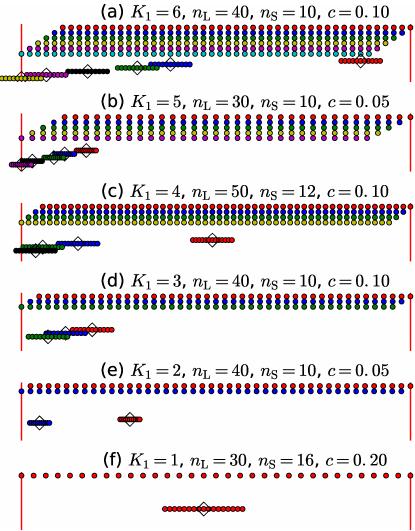
Fig. 1.— Arbitrary tested frequencies. (a) Six highest longer rows show tested frequencies f 1 > f 2 > f 3 > f 4 > f 5 > f 6 for K 1 = 6 signals and n L = 40 in a long search between P − 1 max and (vertical red lines). Six lower shorter rows show short search P − 1 min frequencies for n S = 10 and c = 0 . 10, where diamonds denote best frequency candidates f i , mid detected in long search. Symbol colours are given in Table 1. (b-f) Arbitrary tested frequencies for K 1 = 5 , 4 , 3 , 2 and 1 signals with given n L , n S and c